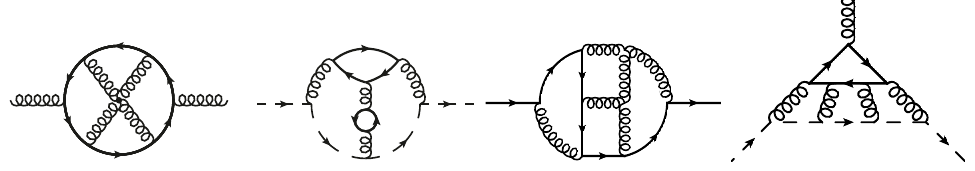
Figure 1 . Sample four-loop diagrams contributing to the decoupling constants de(cid:12)ned in eqs. (3.3) and (3.4). Solid, curly and dashed lines refer to fermions, gluons and ghosts,